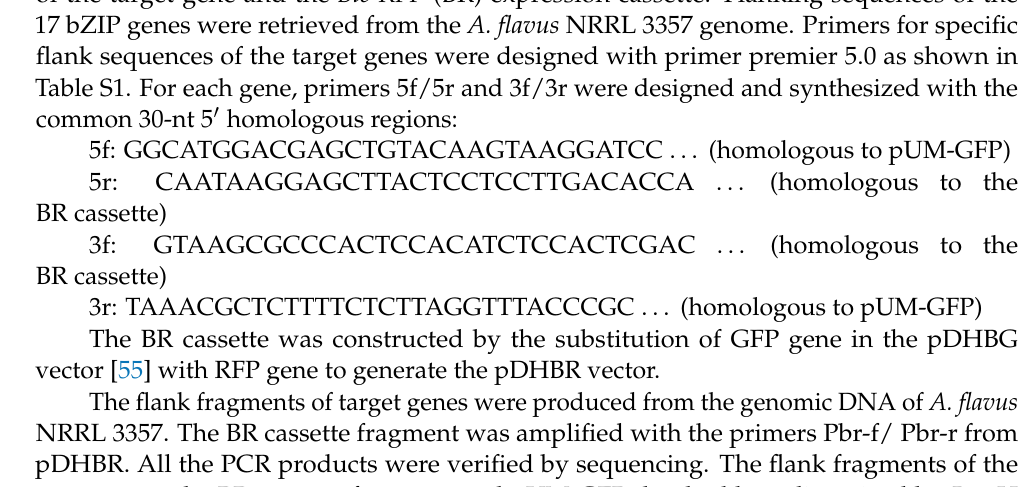
Table S1. For each gene, primers 5f/5r and 3f/3r were designed and synthesized with the common 30-nt 5 (cid:48) homologous